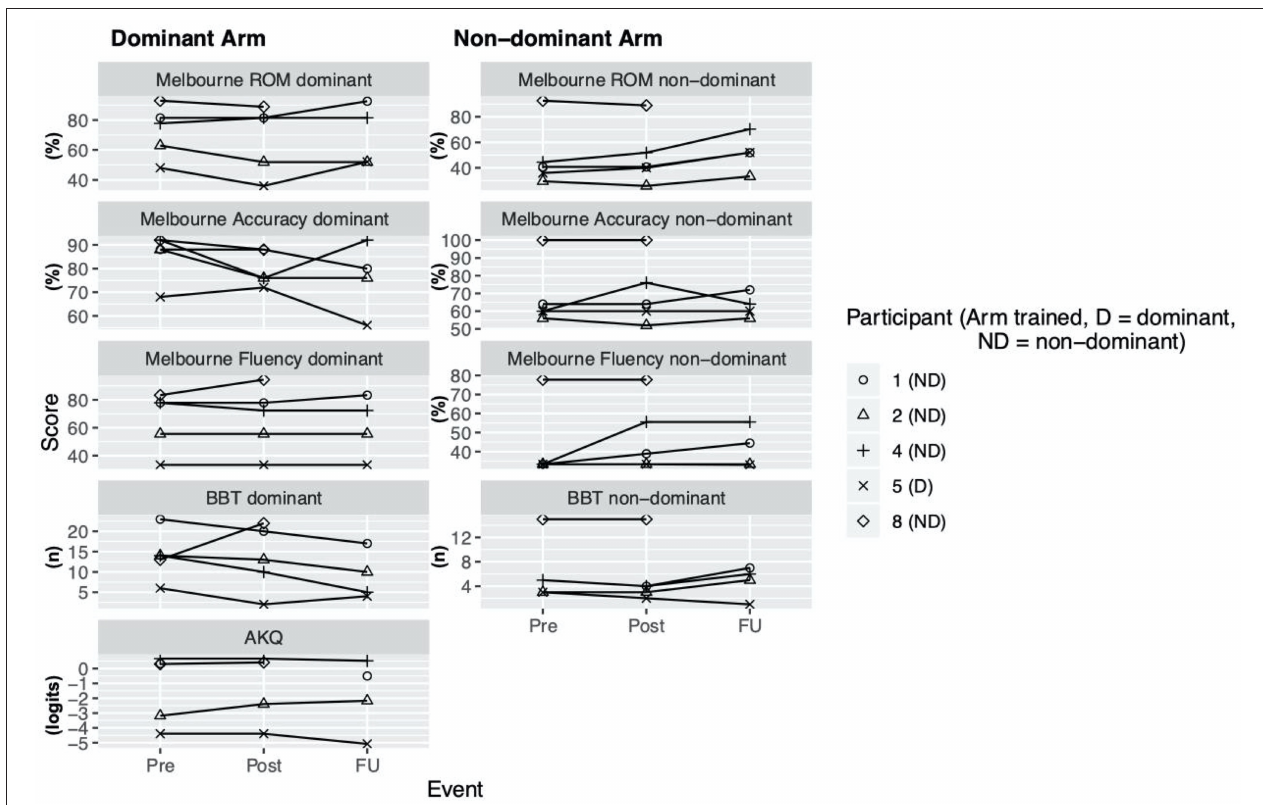
FIGURE 2 | Clinical assessment scores. Scores at assessment events Pre ( = before the intervention), Post ( = 1 week after intervention), delayed follow up (FU) ( = 1 month after intervention) for Melbourne Assessment 2 (Subscores: Range of Movement (ROM), Accuracy, Fluency ), Box and Block test (BBT), ABILHAND Kids Questionnaire